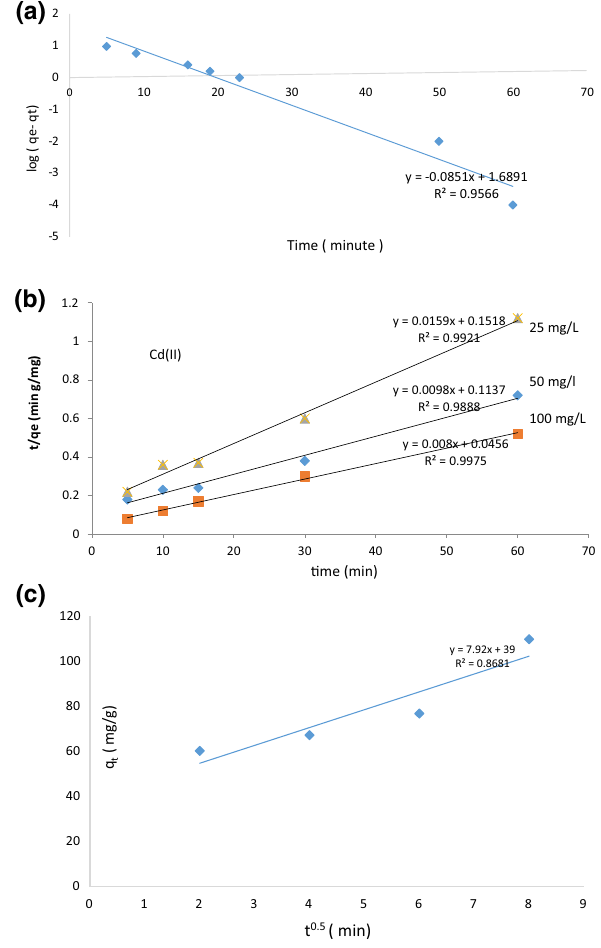
Fig. 6 a Pseudo-first-order plot for adsorption of Cd (II) on algal bio- mass: pH = 4.5, C i = 100 mg/L. dose = 1 g/L, contact time = 60 min at room temperature. b Pseudo-second order plot for adsorption of Cd (II) on algal biomass: pH = 4.5, C i = 25, 50, 100 mg/L. dose = 1 g/L, contact time = 60 min at room temperature. c Intraparticle diffu- sion model for adsorption of Cd (II) on algal biomass: pH = 4.5,